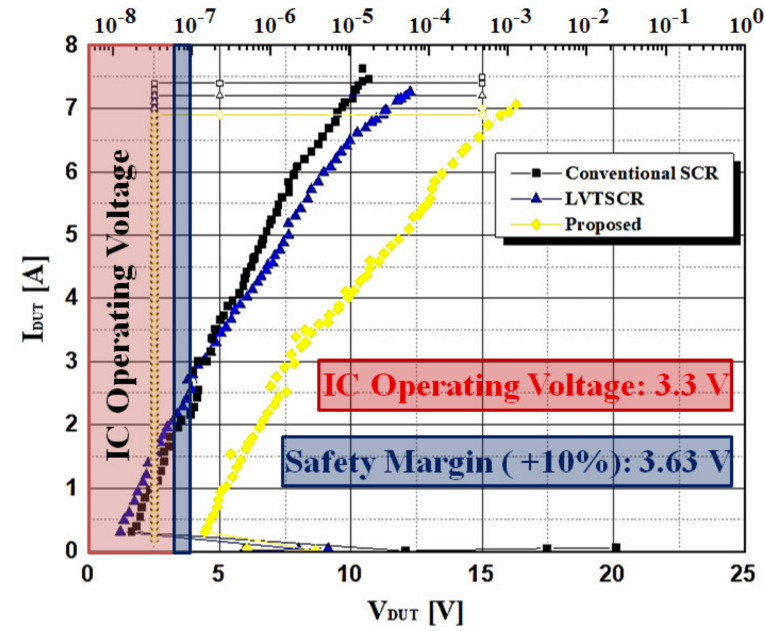
Figure 17. TLP I-V curve of proposed ESD